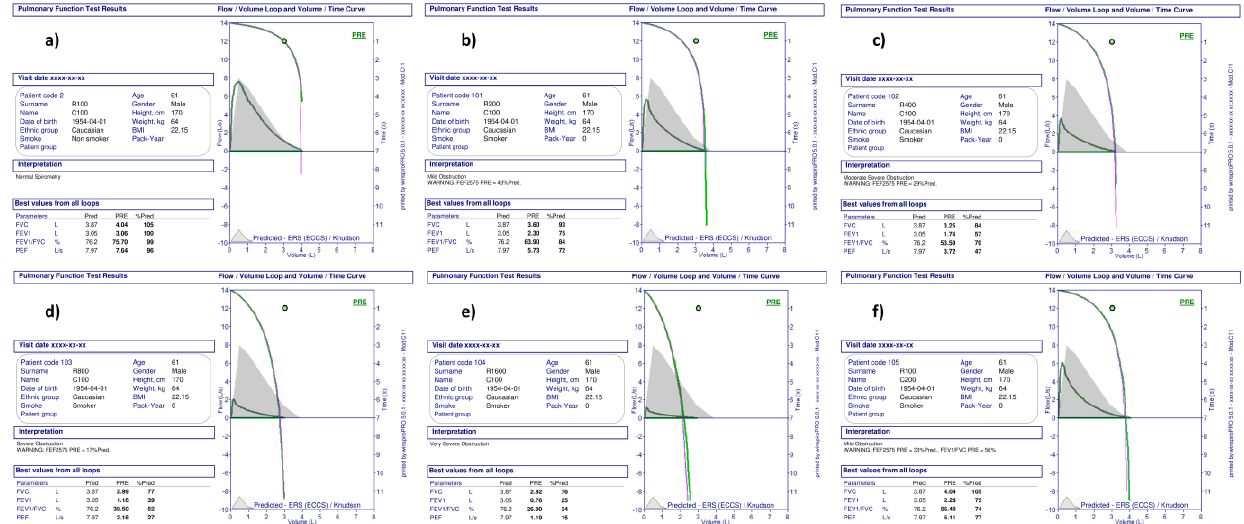
Figure A2. Spirometry measurements of the artificial patient (the hybrid respiratory simulator).